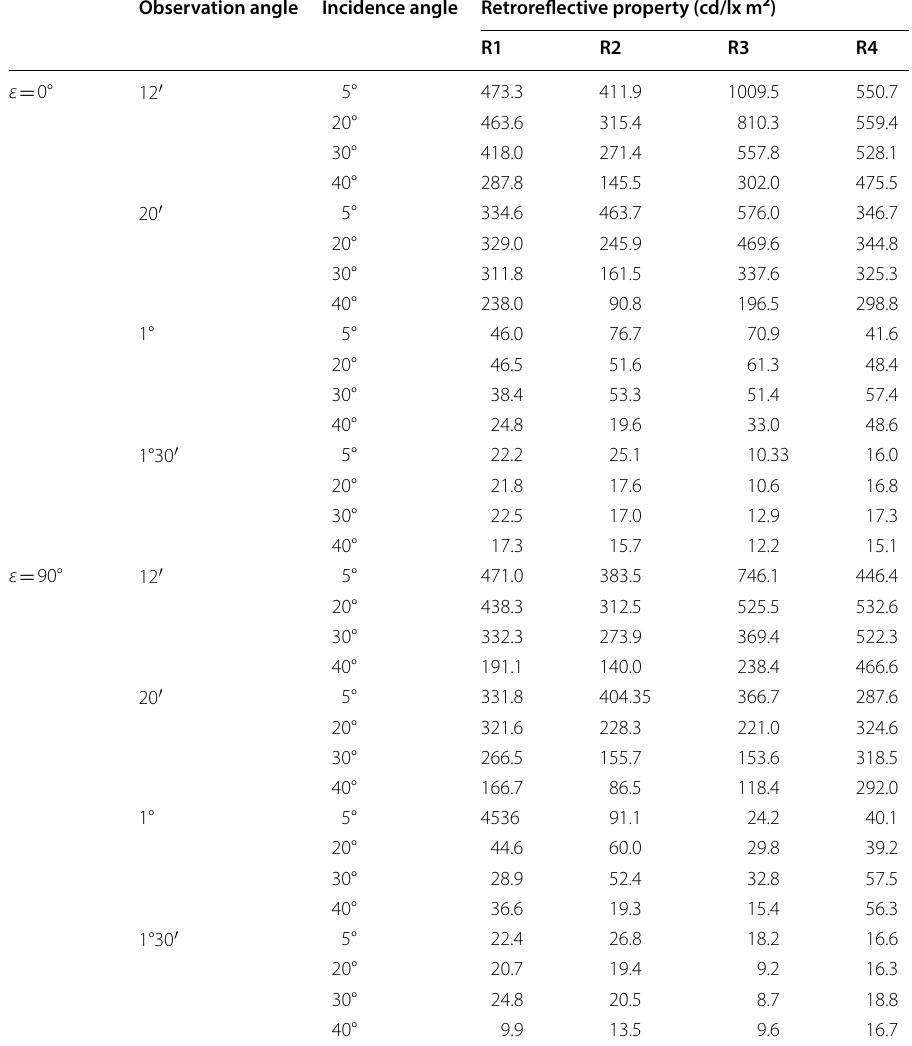
Table 5 General retroreflective property values measured at 0° (frontal light) and 90° (lateral light)